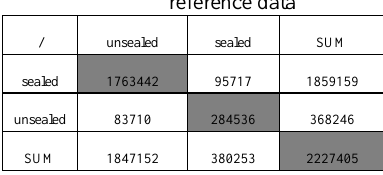
Table 1. Confusion matrix of the pattern based classification of sealed and unsealed